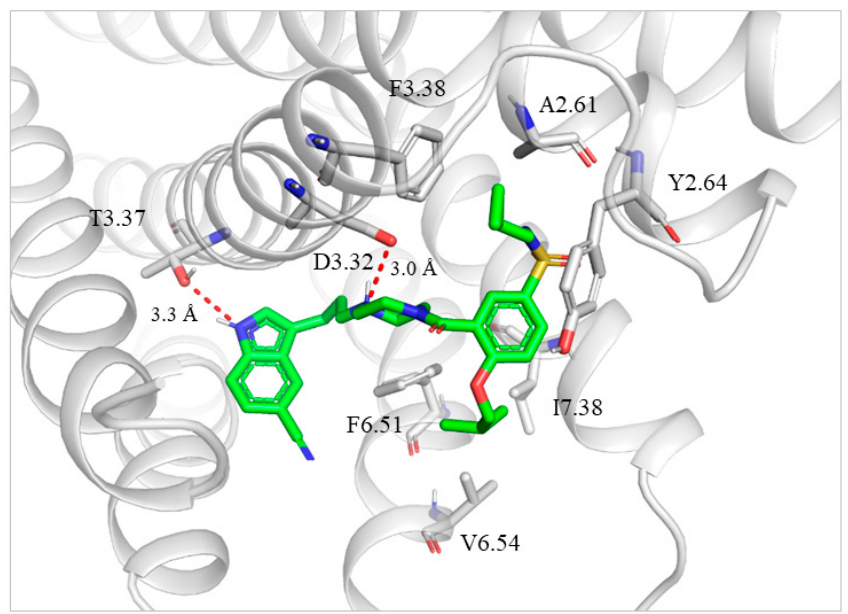
Figure 2. Binding mode of 13m with 5-HT 1A R. The ligand is shown as green sticks. 5-HT 1A R and the surrounding residues are in gray. Hydrogen bond interactions are represented as dotted red lines.